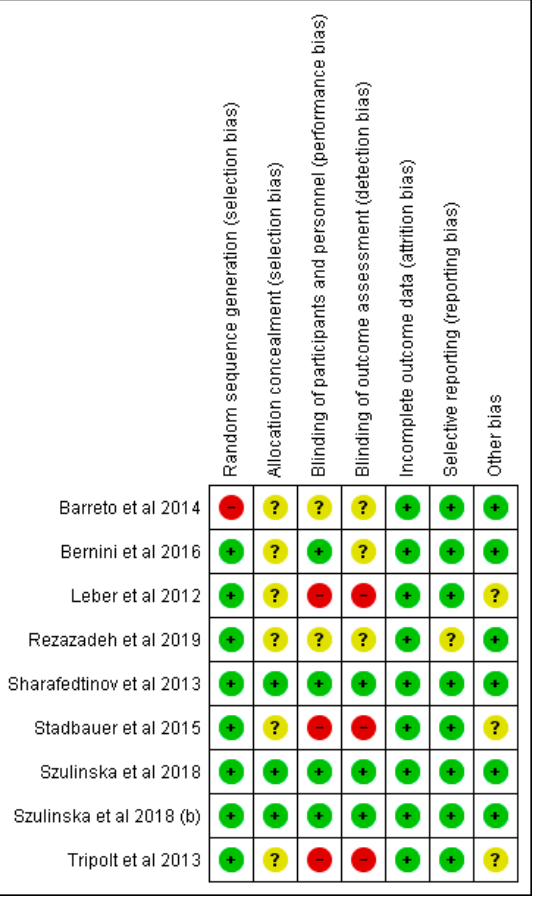
Figure 3. Risk of bias summary: Review authors’ judgments about each risk of bias item for each included study.